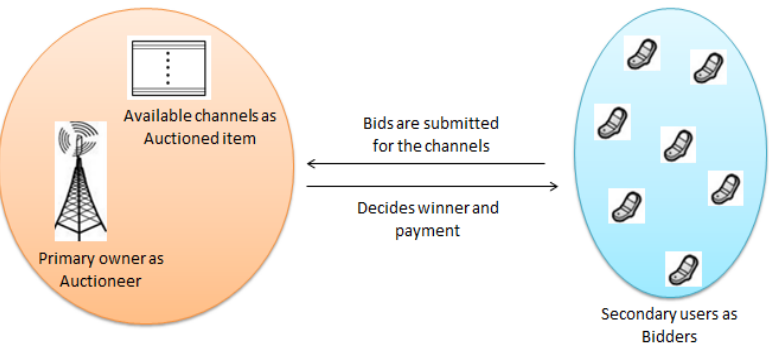
Figure 1. Single-sided auction in cognitive radio